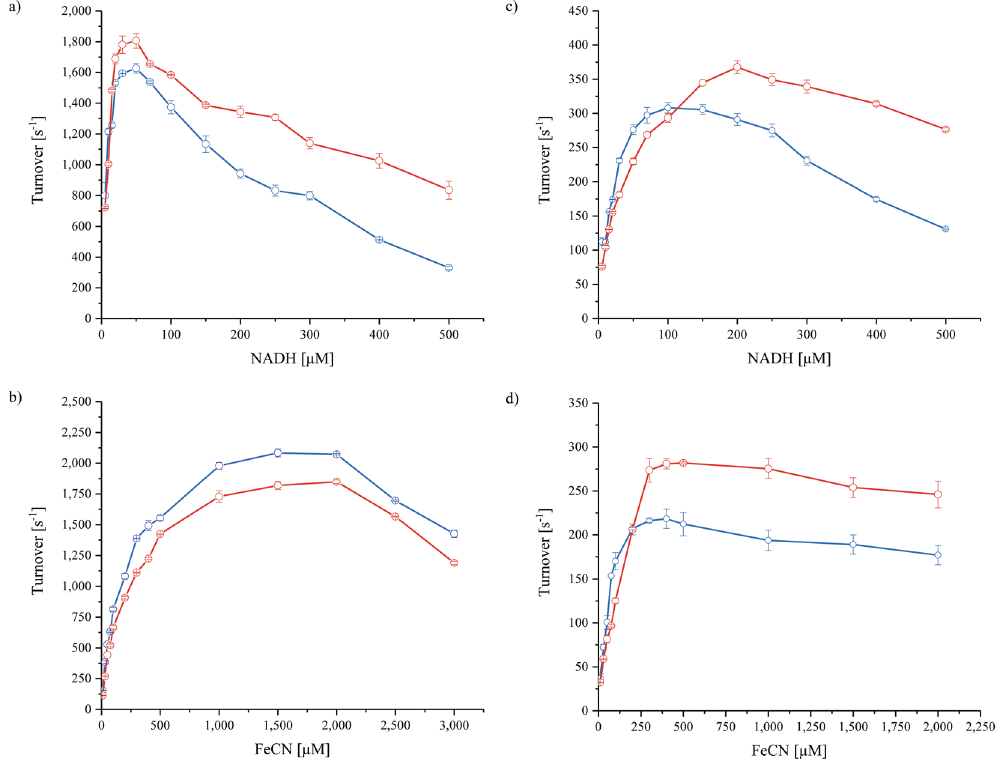
Figure 4. Dependence of the rate of E. coli complex I NADH:ferricyanide oxidoreductase activity on the NADH ( a , c ) and the ferricyanide ( b , d ) concentration. The reaction is either started by enzyme addition ( a , b ) or ferricyanide addition ( c , d ). The concentration of the enzyme was varied to give an appropriate rate for each reaction. The data in ( a , c ) were measured at 0.5 mm (blue) and 1 mm (red) ferricyanide and those in ( b , d ) at 50 µ m (blue) and 100 µ m (red) NADH. The steepness of the fast reaction just prior to substrate depletion was used to draw the plots ( c , d